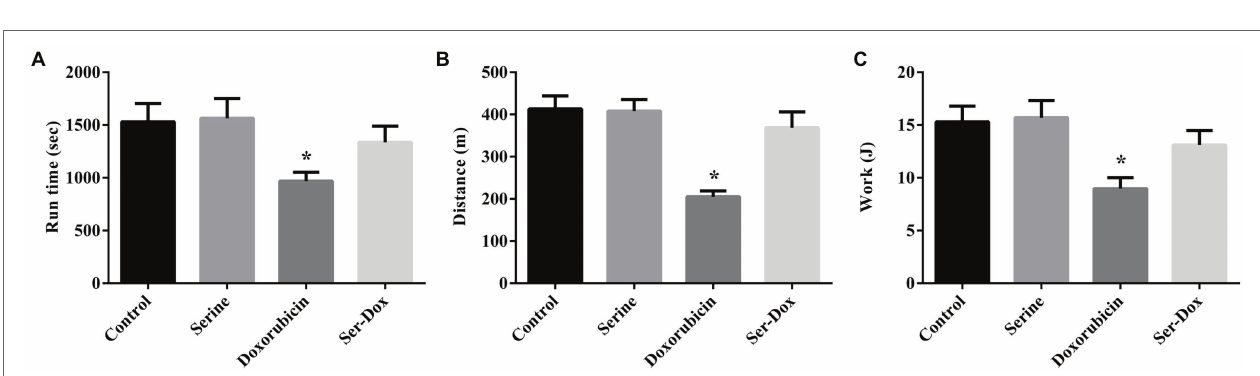
FIGURE 4 | Effects of serine administration on NRF2/CAR signaling in the skeletal muscles of mice. Representative protein lanes of NRF2/CAR signaling in the skeletal muscles of mice (A) ; Relative protein expression of nuclear CAR (B) , nuclear NRF2 (C) , total CAR (D) , total NRF2 (E) , and total Keap1 (F) . Values are expressed as LSmean plus pooled SEM, n = 3. *Mean values were significantly different among groups ( p < 0.05). CAR, constitutive-androstane-receptor; Keap1, Kelch like ECH-associated protein 1; and NRF2, nuclear-factor-erythroid-2-related factor 2.